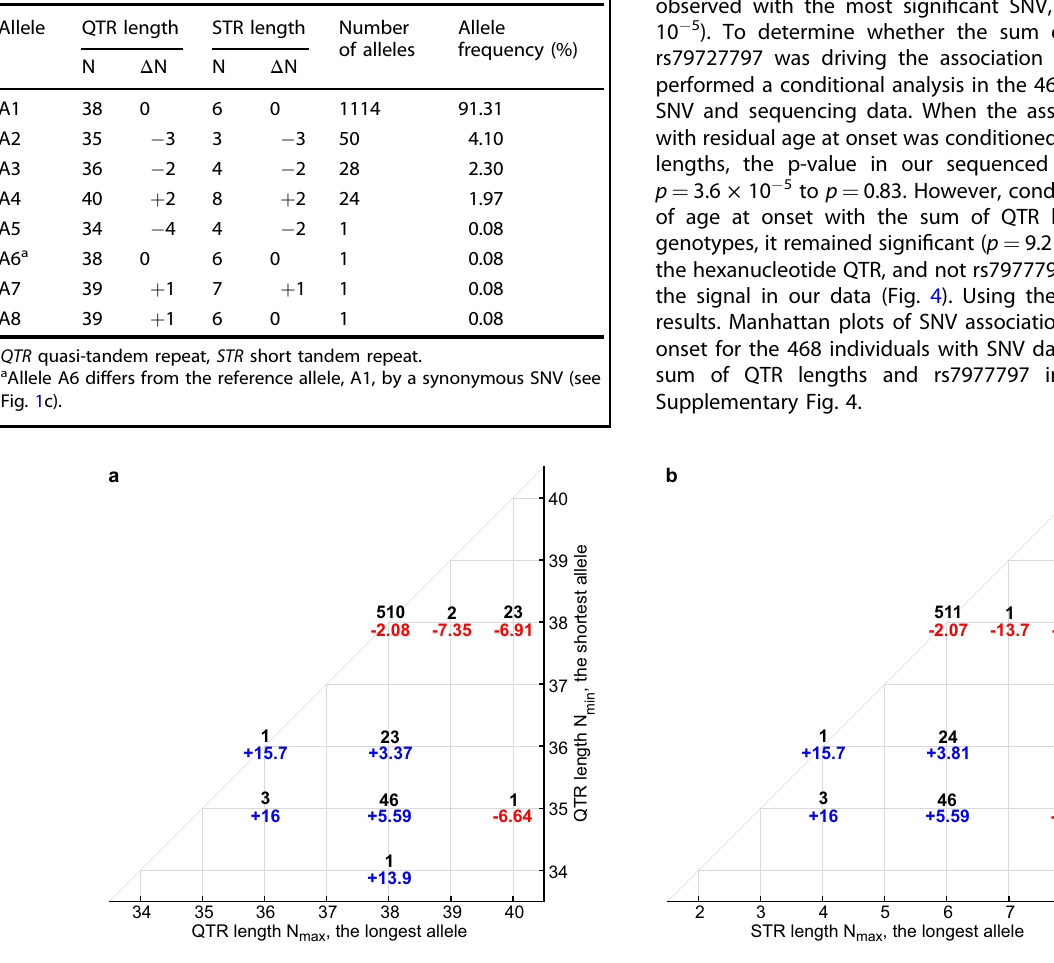
Fig. 2 TCERG1 tandem repeat genotype counts and associated mean residual ages at onset. a Quasi-tandem repeat (QTR) genotypes. b Short tandem repeat (STR) genotypes. Black numbers mark genotype counts. Red and blue numbers indicate mean residual ages at onset for individual genotypes, early onset in red, late onset in blue.